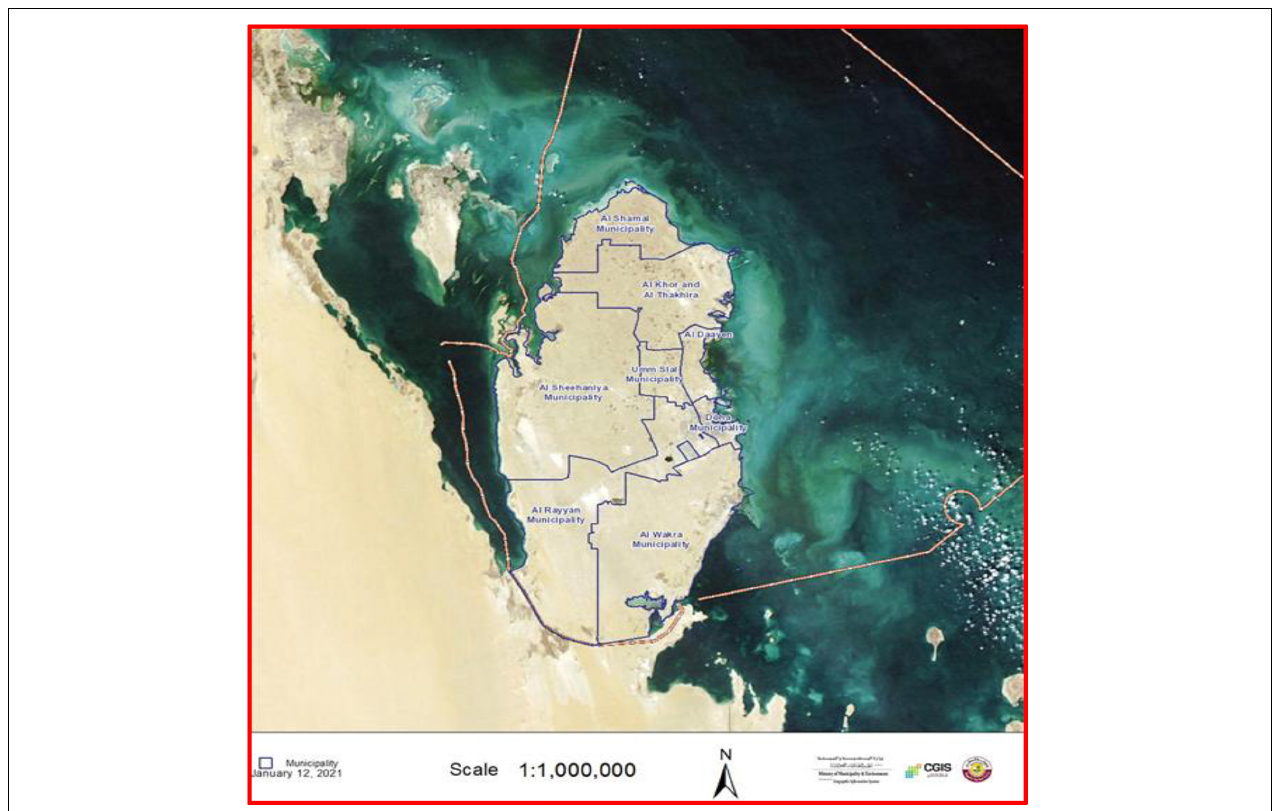
FIGURE 1 | Qatar as extended land from the Arabia peninsula. Qatar is largely surrounded by seawater of the Arabian